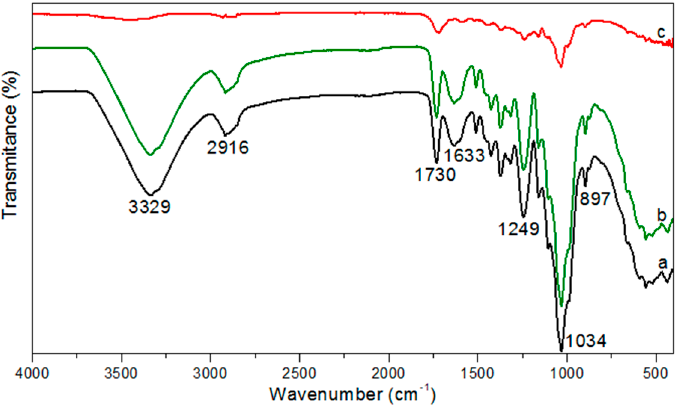
Figure 10. FTIR spectra ( a ) CP; ( b ) CPNaOH; ( c ) CPNaOHT.